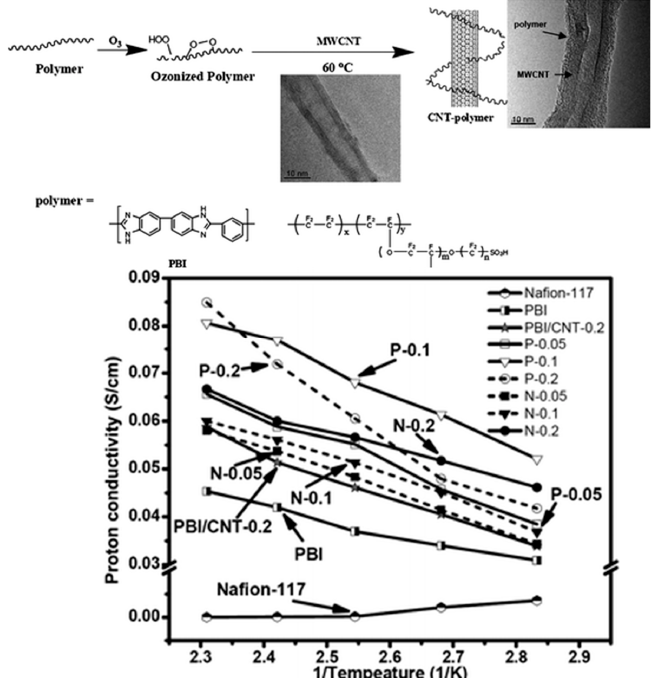
Figure 19. Schematic representation of preparation of sulfonated Nafion ® - and PBI-functionalized multiwalled carbon nanotubes (MWCNTs) (top) and proton conductivity of different composite membranes at 80–160 °C without humidification (bottom). Reproduced from [174] with permission of the Royal Society of Chemistry.